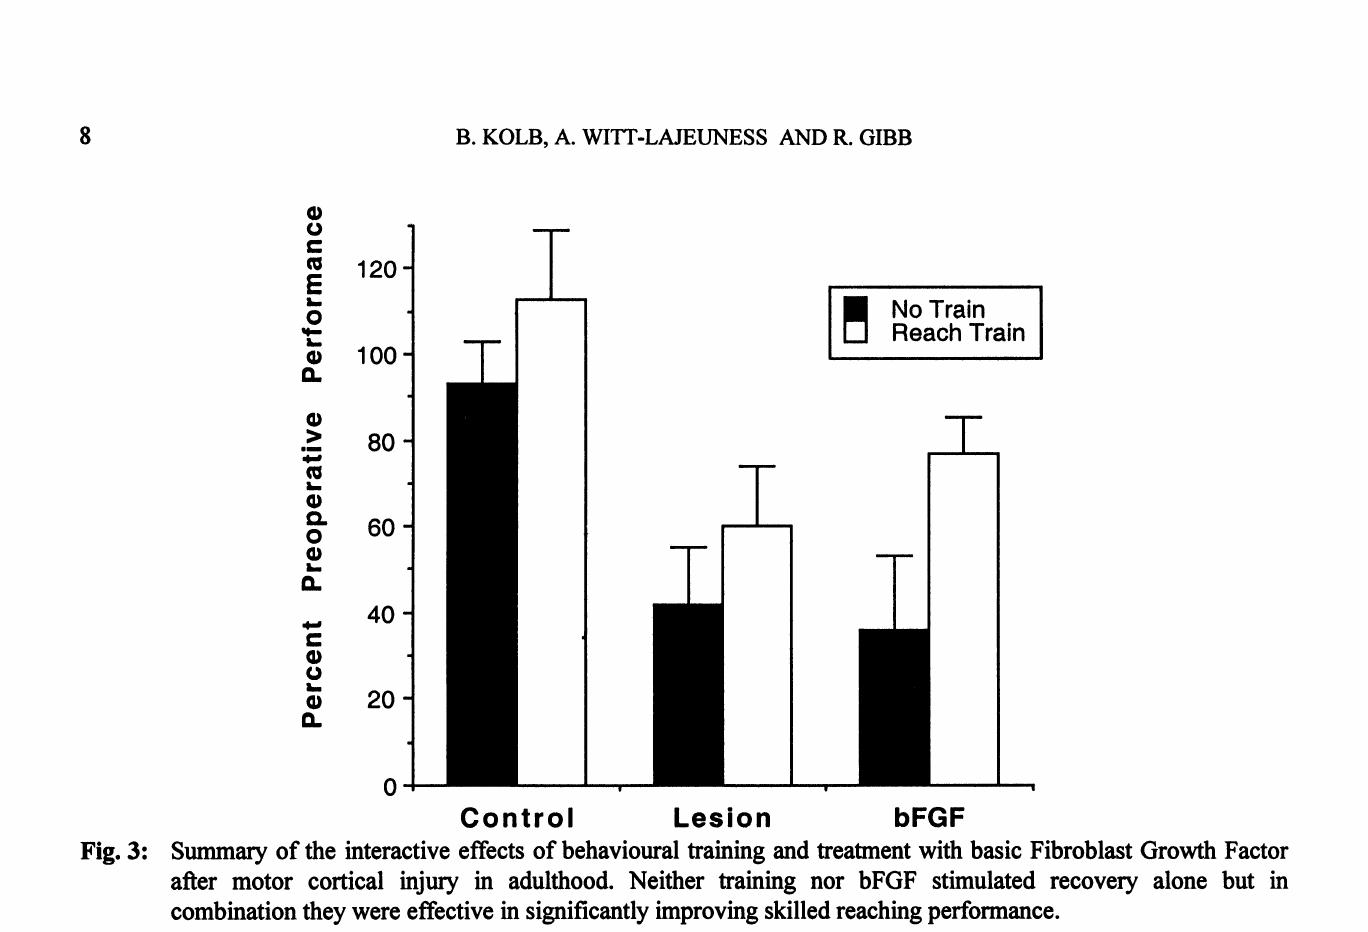
Fig. 3: Summary of the interactive effects of behavioural training and treatment with basic Fibroblast Growth Factor after motor cortical injury in adulthood. Neither training nor bFGF stimulated recovery alone but in combination they were effective in significantly improving skilled reaching